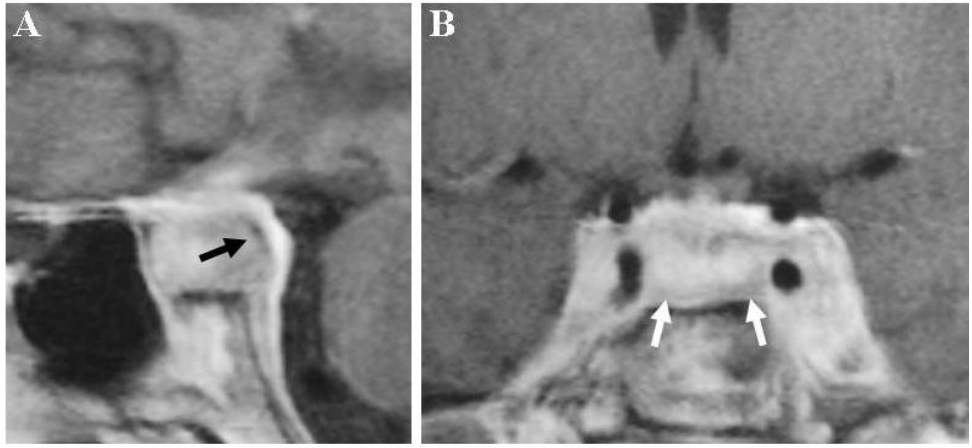
FIGURE 4. MRI evaluation after azathioprine treatment. (A) Sagittal FSE T1-weighted image after Gd-DTPA administration shows inflammatory tissue with a strong enhancement still visible inside adenohypophysis and left cavernous sinus. The gland is enlarged. The dural tail sign is still present (black arrow). (B) Coronal FSE T1-weighted image after Gd-DTPA administration demonstrating the hypointense rim, possibly fibrotic, also visible inside the parenchyma (white